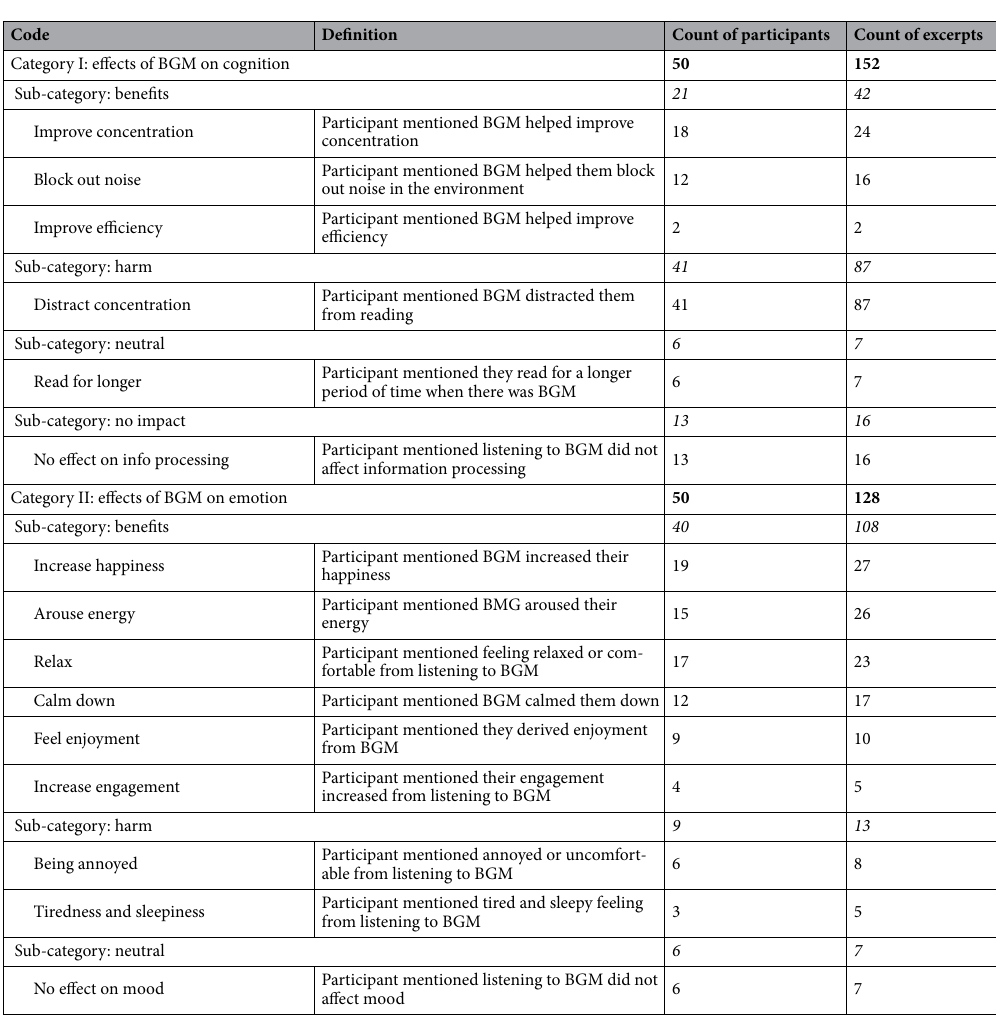
Table 10. Thematic analysis results of interviews. Aggregated values for each Category and Sub-category are in bold and italics